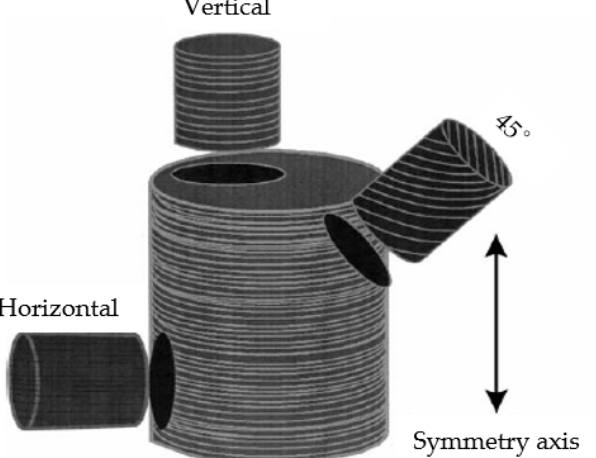
Figure 1. Traditional measurement methods sample the same core in different directions.